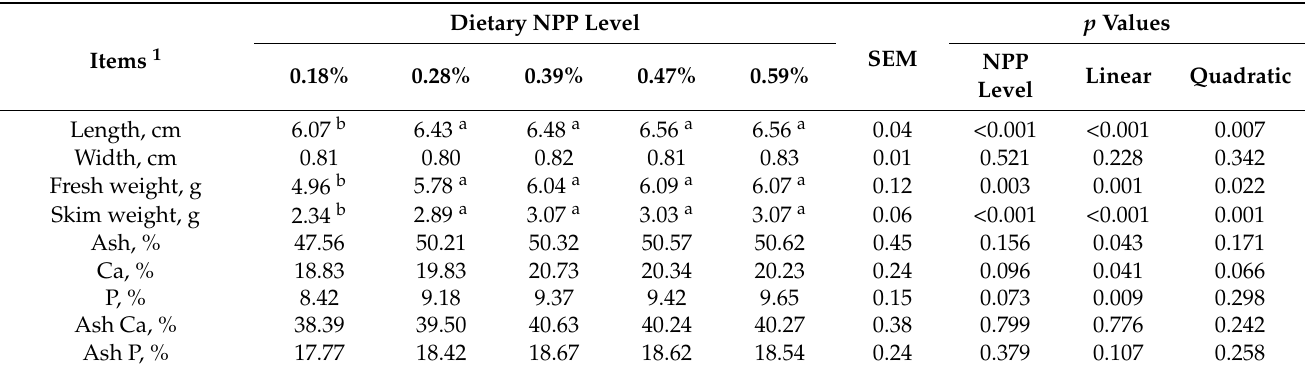
Table 5. Effects of dietary non-phytate phosphorus (NPP) levels on the femur variables of 28-day- old